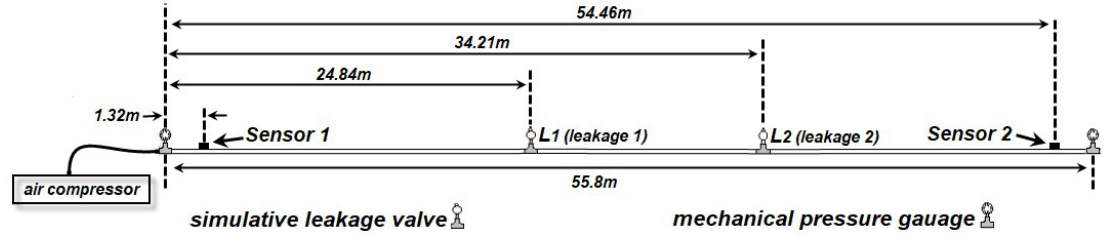
Figure 3. Schematic diagram of the measured experiment. Table 1. Coordinates of sensors and leakages.